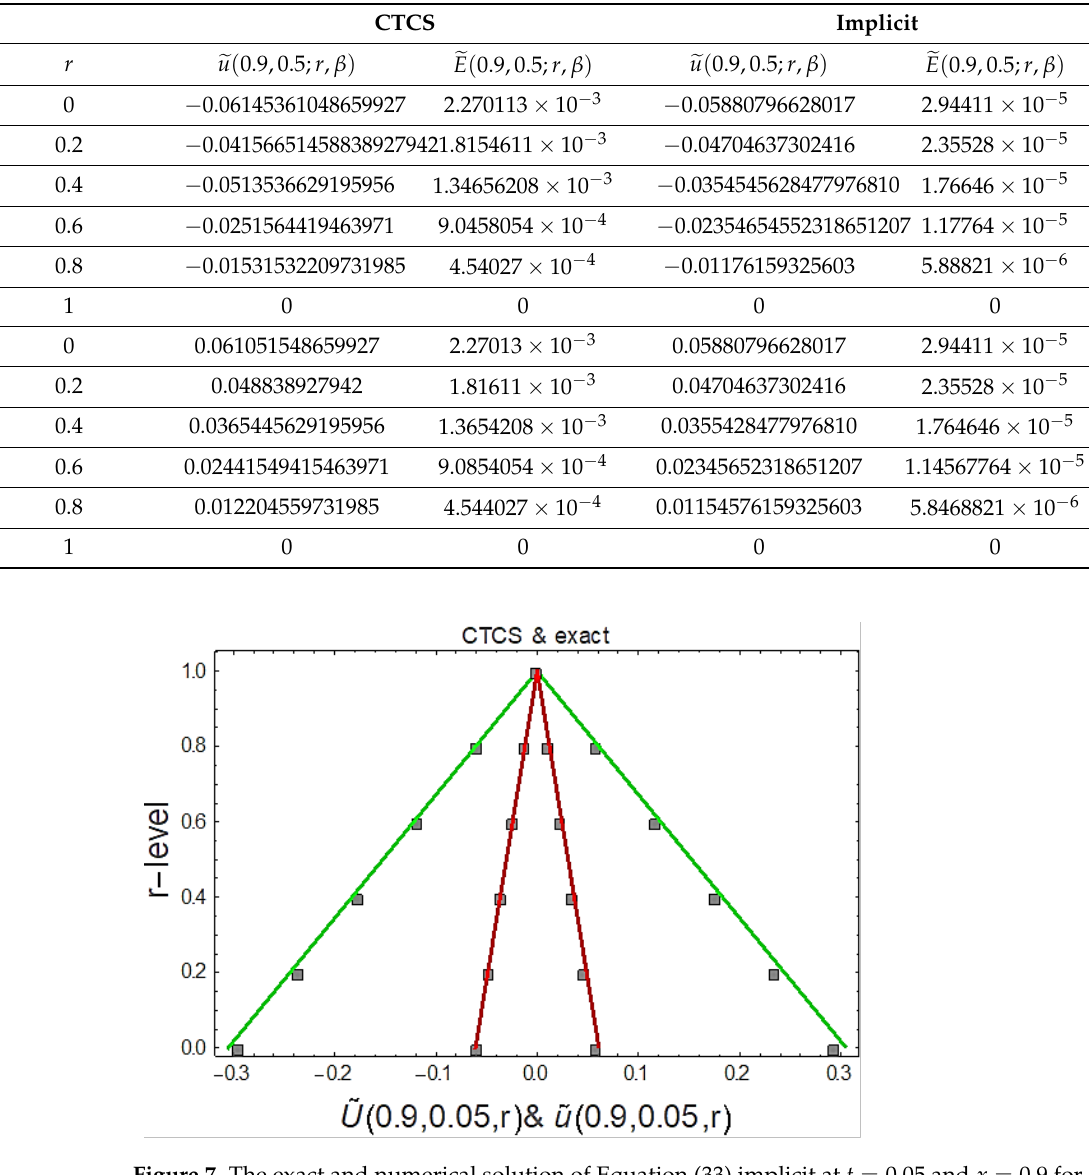
Figure 7. The exact and numerical solution of Equation (33) implicit at 𝑡 = 0.05 and 𝑥 = 0.9 for all 𝑟, 𝛽 ∈ [0,1] .